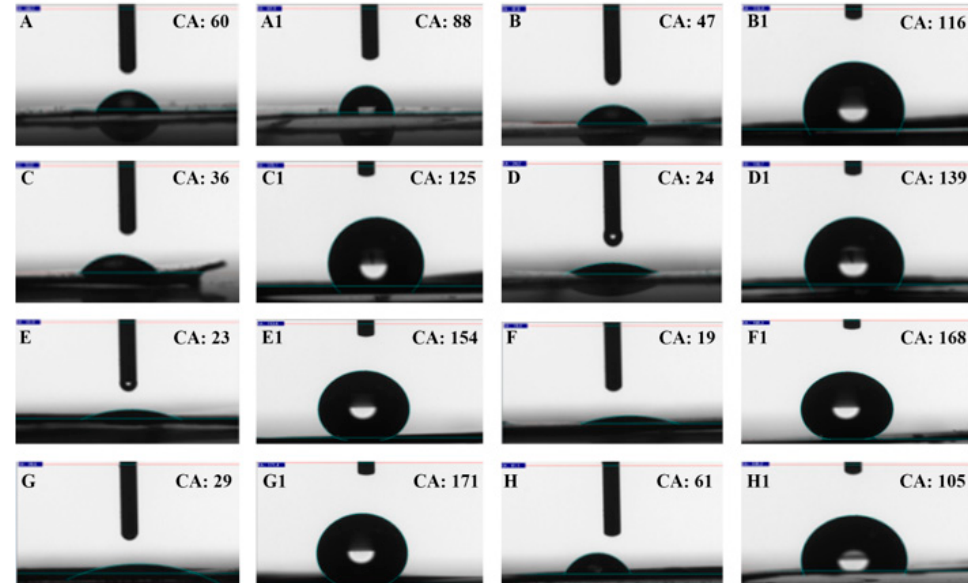
Figure 2. The contact angles of water on the prepared plates with different magnitude of current: ( A ) 0 A, ( A1 ) modification by lauric acid on ( A ); ( B ) 1 A, ( B1 ) modification by lauric acid on ( B ); ( C ) 2 A, ( C1 ) modification by lauric acid on ( C ); ( D ) 3 A, ( D1 ) modification by lauric acid on ( D ); ( E ) 4 A, ( E1 ) modification by lauric acid on ( E ); ( F ) 5 A, ( F1 ) modification by lauric acid on ( F ); ( G ) 6 A, ( G1 ) modification by lauric acid on ( G ); ( H ) 7 A, ( H1 ) modification by lauric acid on ( H ).